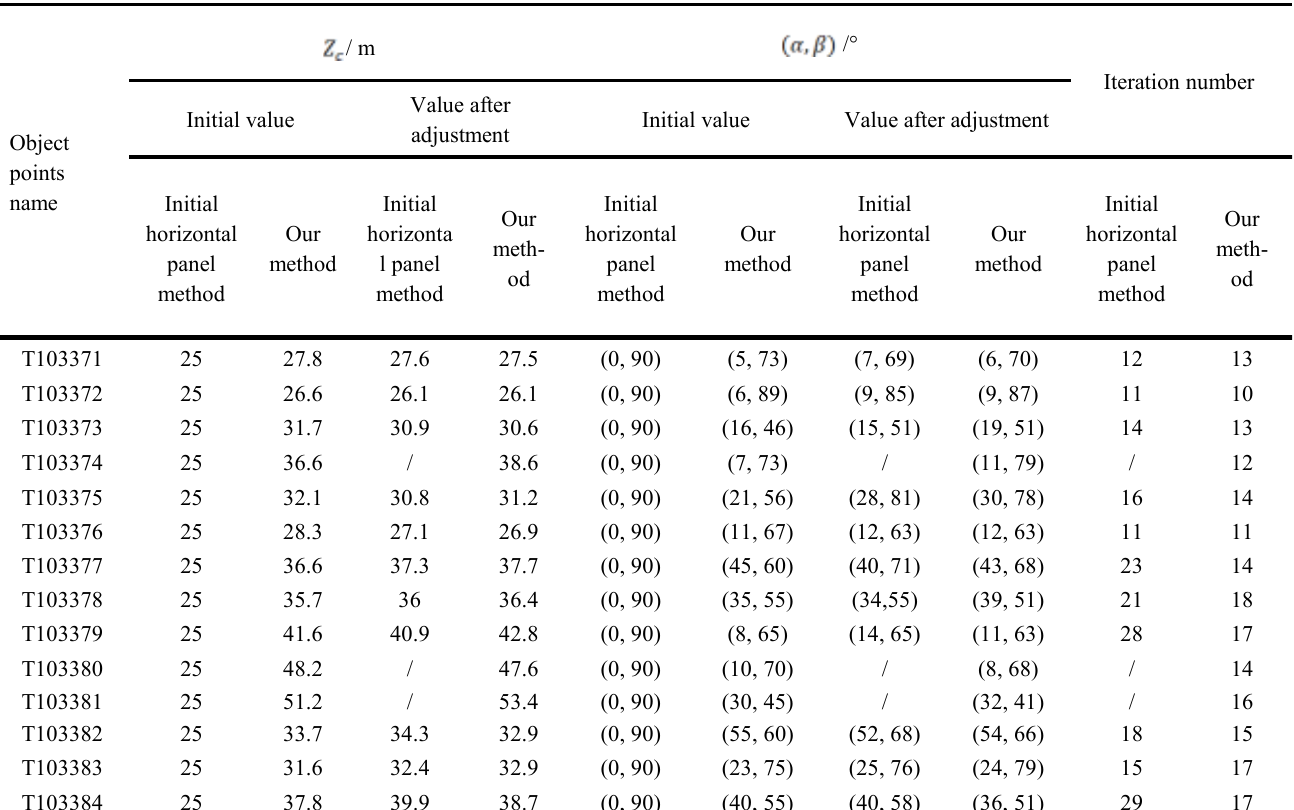
Table5. The effect of the accuracy of the initial value on the matching results